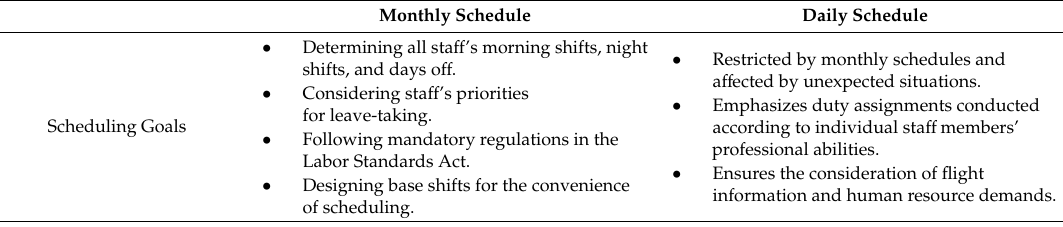
Table 3. Comparison between monthly and daily